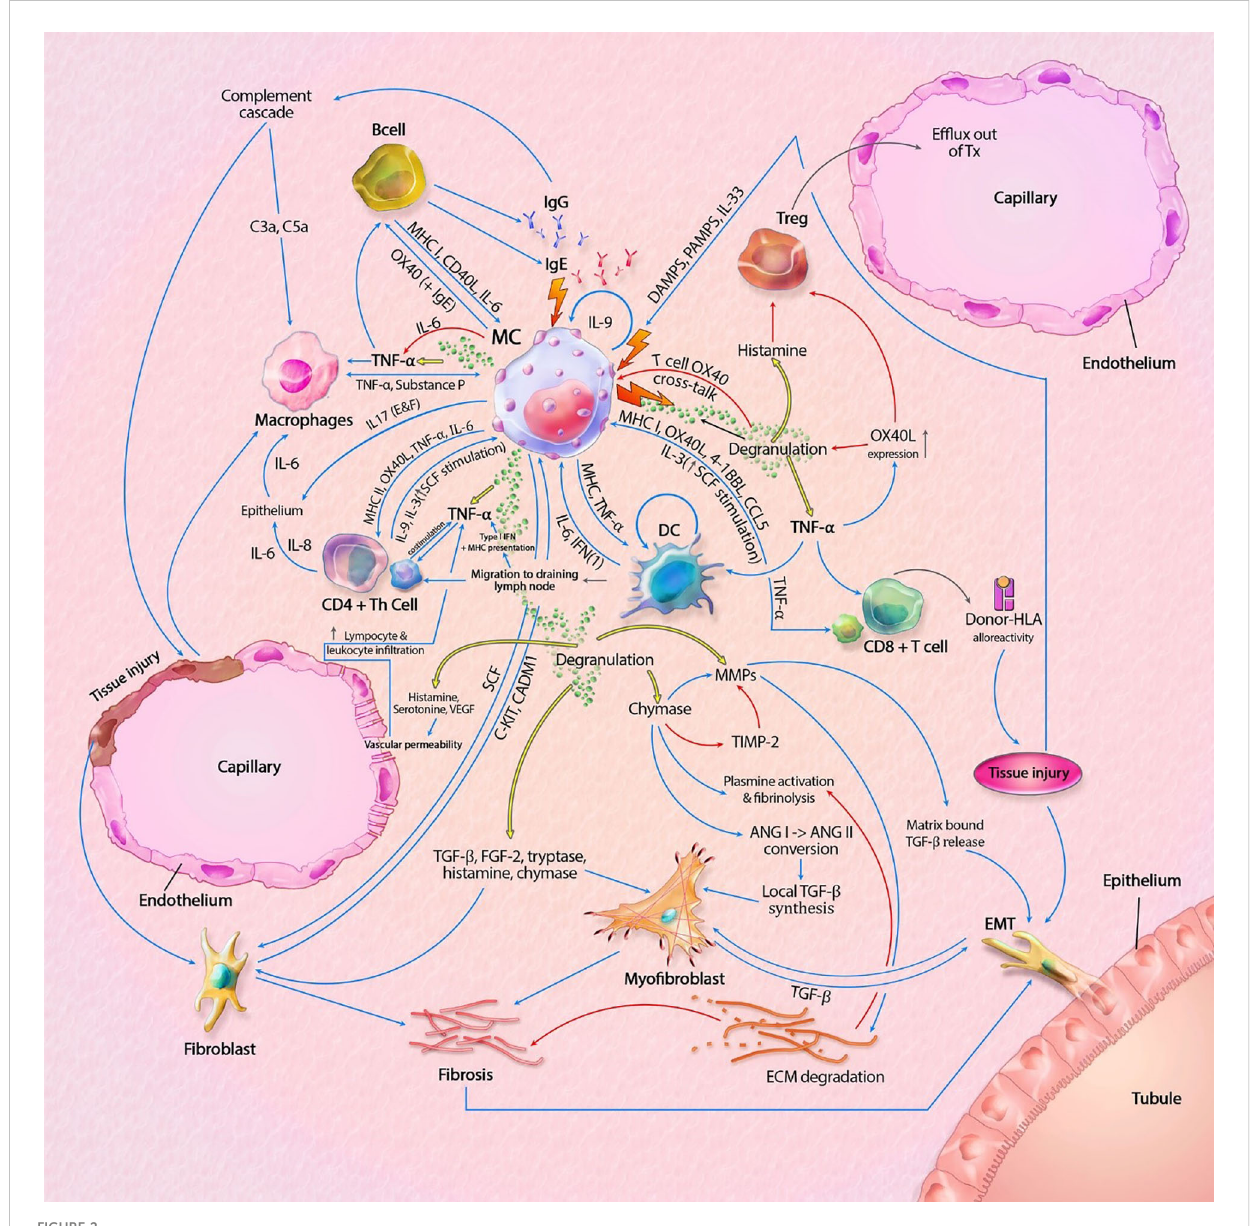
FIGURE 2 Mast cell (MC) interactions within the graft during rejection. Pathways can include both cytokines (like TNF- a ) and membrane bound interaction (like MHC I-TLR interaction). MC-T cell interaction through OX40L-OX40 cross-linking inhibits MC degranulation, represented by the inhibitory pathway towards degranulation. Innate immune cells can also result in tissue injury, which is not shown in this model. Interaction between APCs, T cells and B cells, resulting in antigen production is also not shown in this model. The model shows almost no inhibitory pathways, explaining the progressive state of fi brosis within KTx even when immunosuppressive drugs are taken. Detailed description of the model can be found within the text. ANG, angiotensin; C3a/C5a, complement component; ECM, extracellular matrix; EMT, epithelial-mesenchymal transition; FGF-2; fi broblast growth factor- 2; Ig, immunoglobulin; IL, interleukin; MHC, major histocompatibility complex; MMPs, matrix metalloproteinase; SCF, stem cell factor; tDC, tolerogenic dendritic cell; TGF- b , tissue growth factor beta; Th cell, T helper cell; TIMP-2, tissue inhibitor of metalloproteinase-2; TNF- a , tissue necrotic factor alpha; Treg, regulatory T cell (natural); VEGF, Vascular Endothelial Growth Factor. Blue lines symbolize activating pathways, red lines inhibitory pathways, yellow lines represent pre-formed mediators within MCs. Grey lines represent subsequent events. Lighting icons are used in the most profound activation